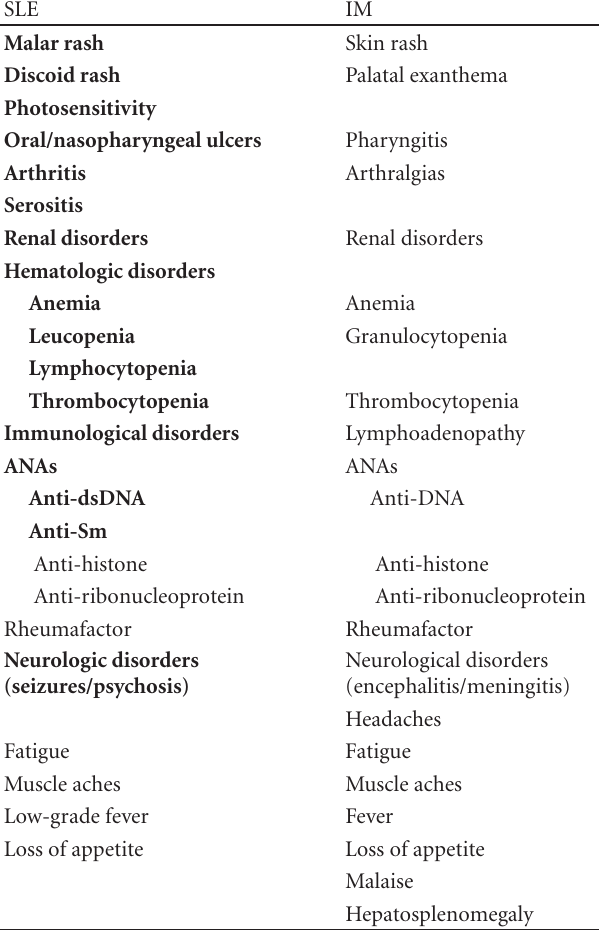
Table 1: Symptoms and clinical manifestations of SLE ∗ [3, 4, 6] and IM